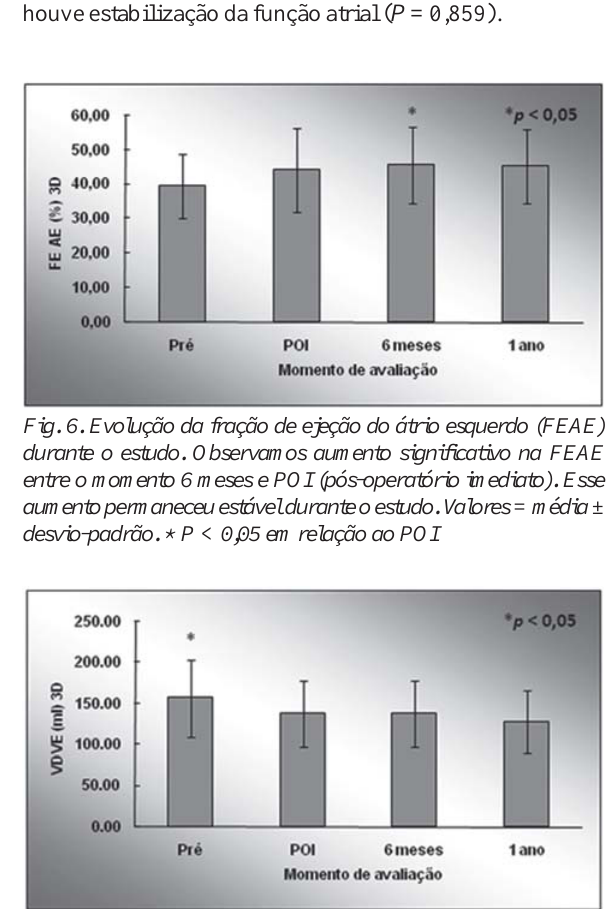
Fig. 7. Evolução do volume sistólico final do ventrículo esquerdo (VSVE) durante o estudo. Observamos redução significativa no VSVE entre o momento 6 meses e POI (pós-operatório imediato) e 1 ano e POI. Valores = média ± desvio-padrão. * P < 0,05 em relação ao POI